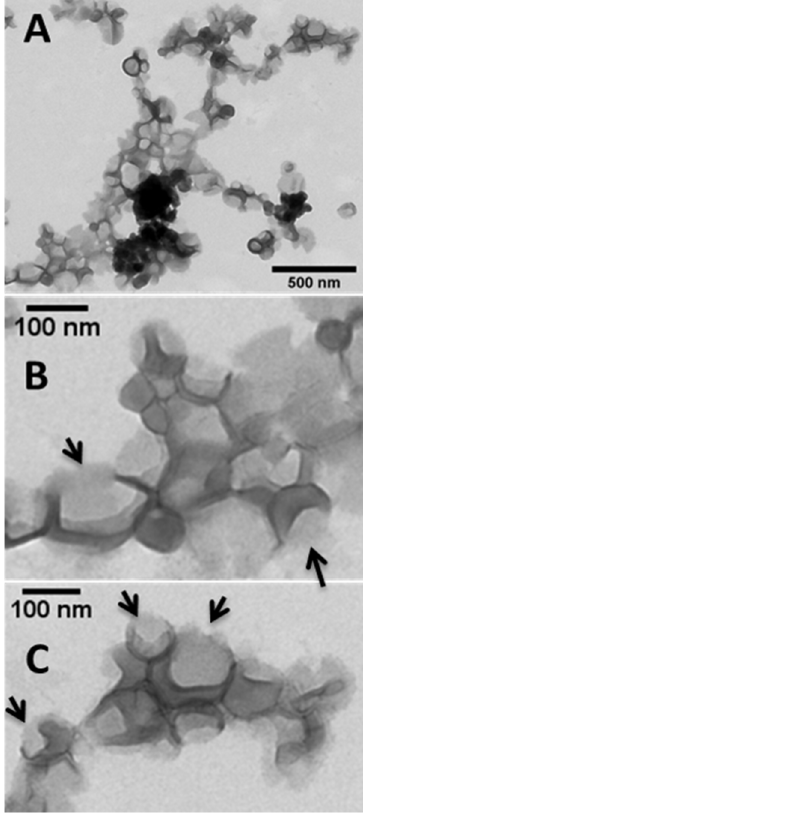
Figure 6. TEM images ( A – C ) showing morphology of Lip-PFP-Dox-MSNPs, where the arrows in ( B , C ) indicate the areas of lipid bursting after US-irradiation.